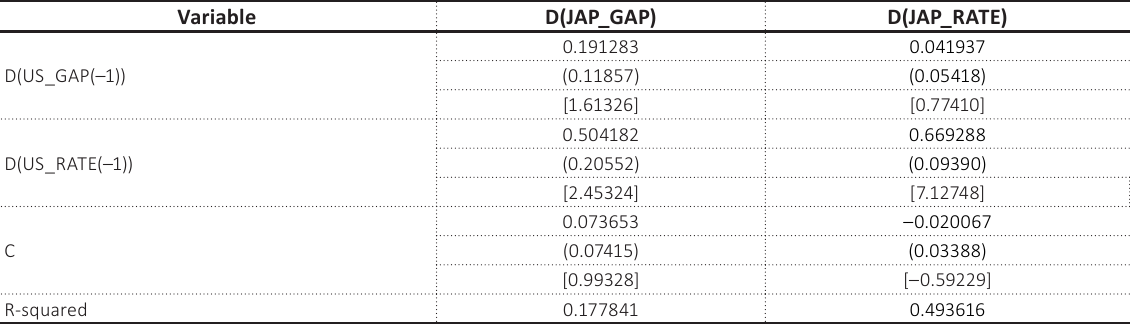
Table A4.3. VAR model assessed for the